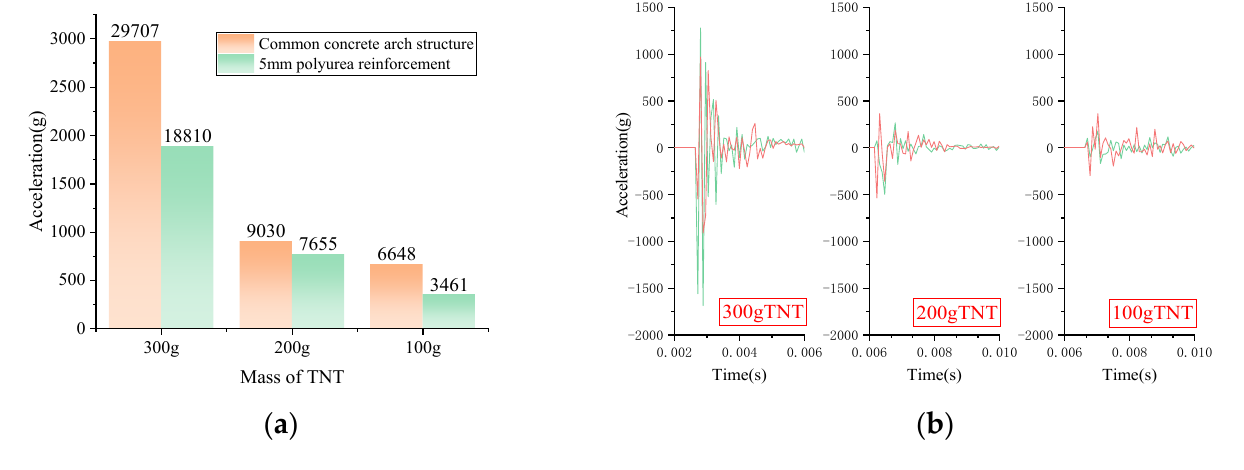
Figure 14. Acceleration in the Y ‐ direction, i.e., vertical ( a ) Maximum variation of acceleration at the inner side of the vault. ( b ) Dynamic acceleration curve of the vault. (Three different conditions)